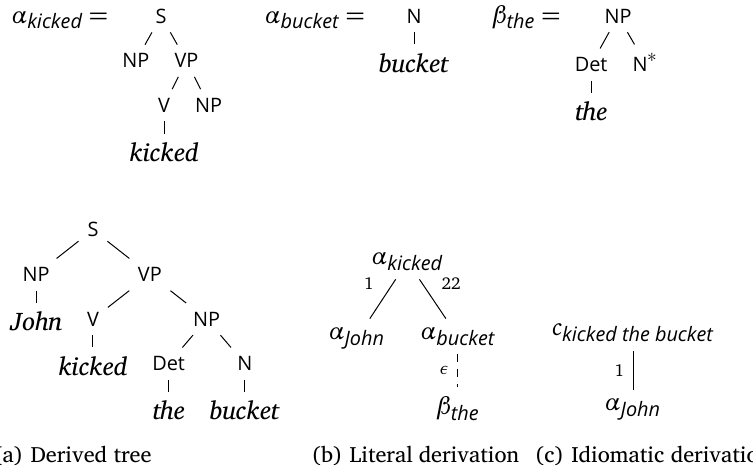
Figure 29: Elementary trees to analyze kick the bucket